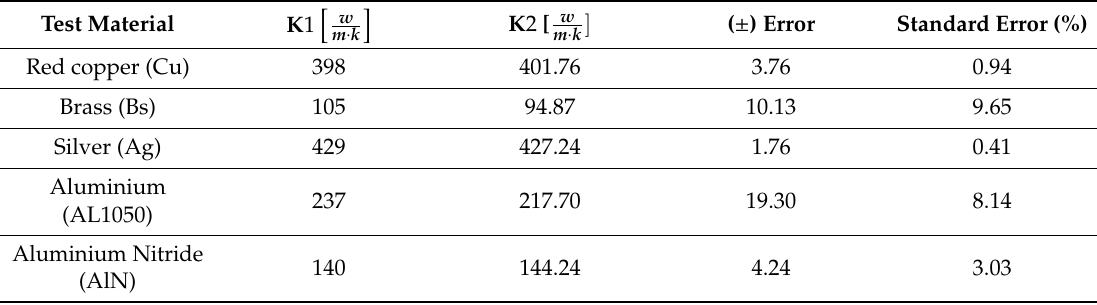
Table 3. Comparison of thermal conductivity between measured and actual